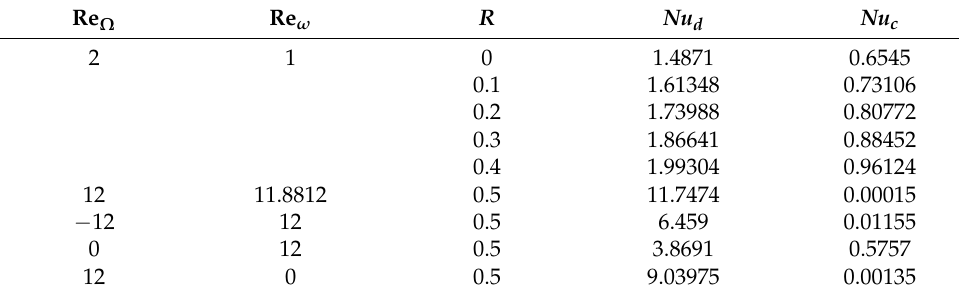
Table 4. Effects of Re Ω , Re ω , and R on Nu d and Nu c .